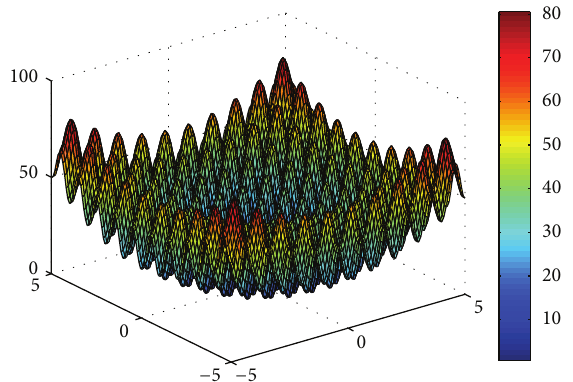
Figure 6: A noncollision avoidance scenario in open waters.